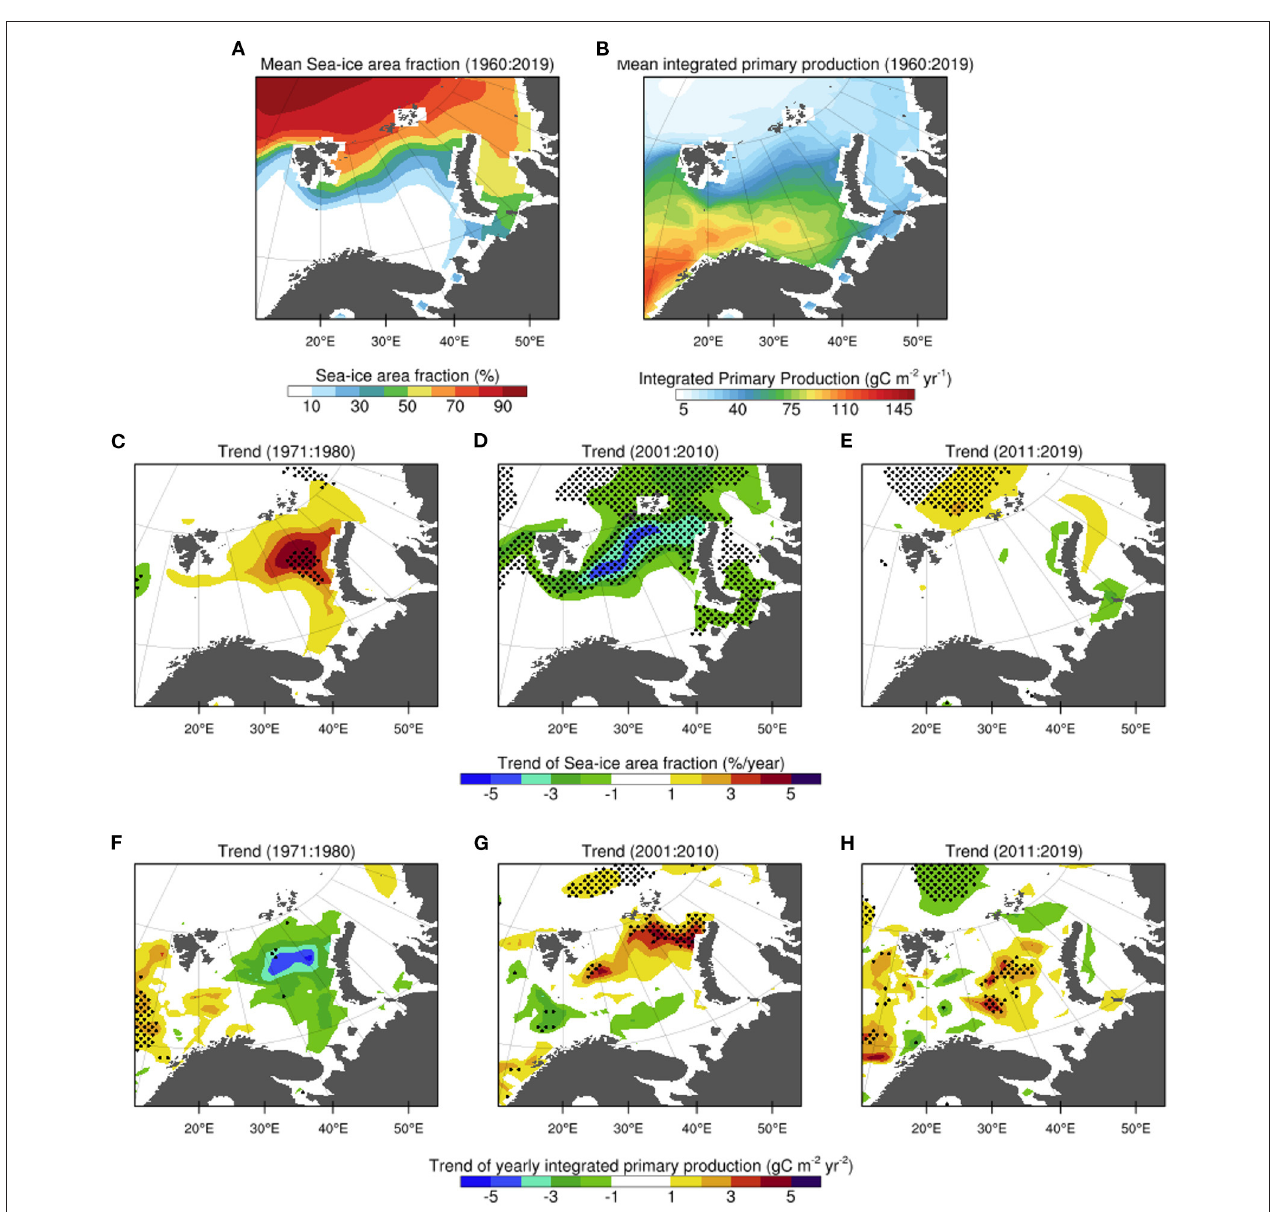
FIGURE 7 | (A) Climatology of the annual mean sea-ice concentration (percent of grid cell occupied by sea-ice) and (B) integrated net primary production (gCm − 2 yr − 1 ) for the period 1960–2019 from the assimilation experiment. Trends in annual mean sea-ice concentration (second row) and integrated net primary production (third row) for the three periods (C,F) 1971–1980, (D,G) 2001–2010, and (E,H) 2011–2019. The stippling marks statistically significant trends at 90% confidence